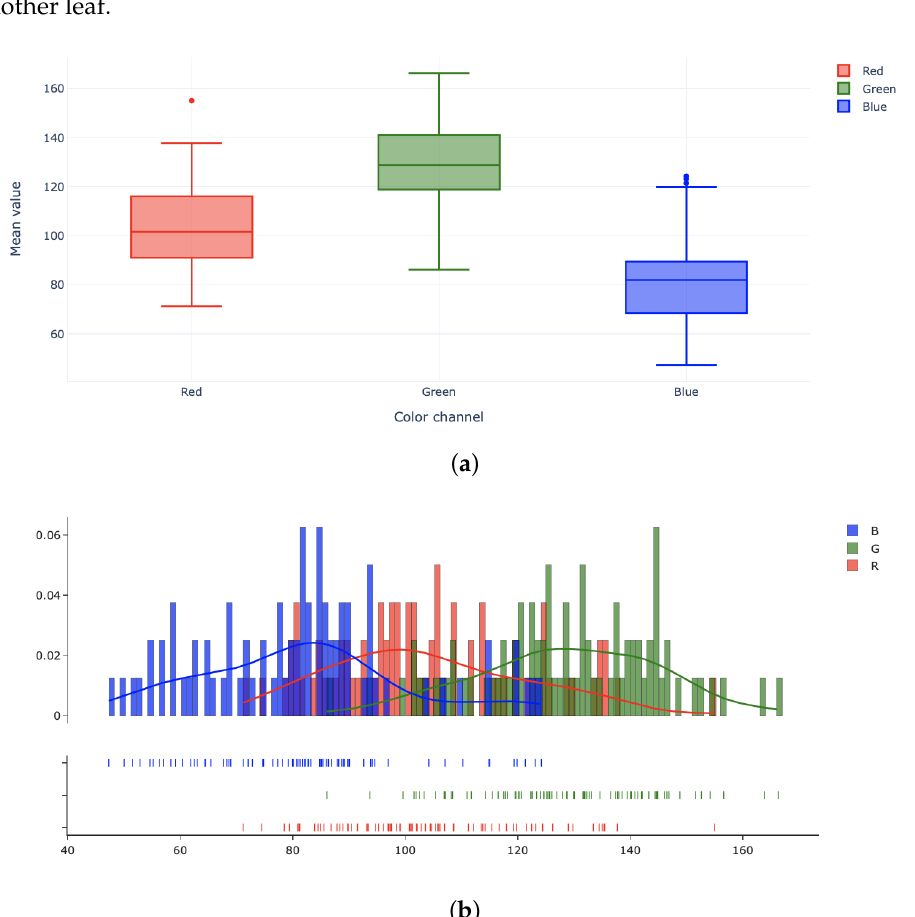
Figure 5. Distribution of cluster channels ( a ) and (misclassification) ( b